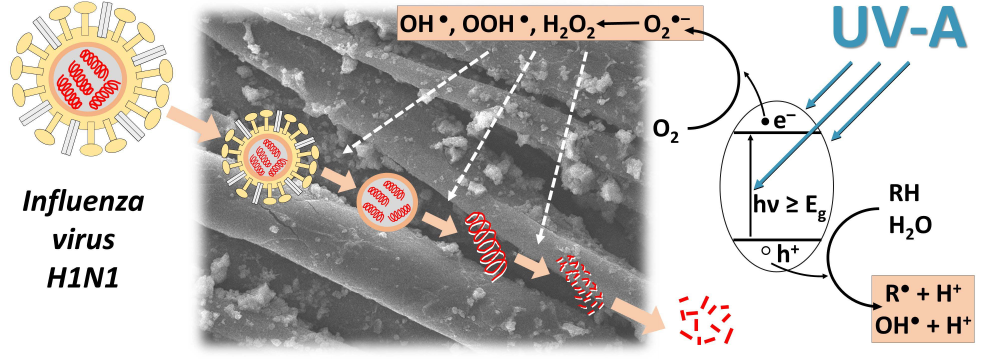
Figure 5. Scheme of virus degradation on the irradiated surface of photoactive cotton